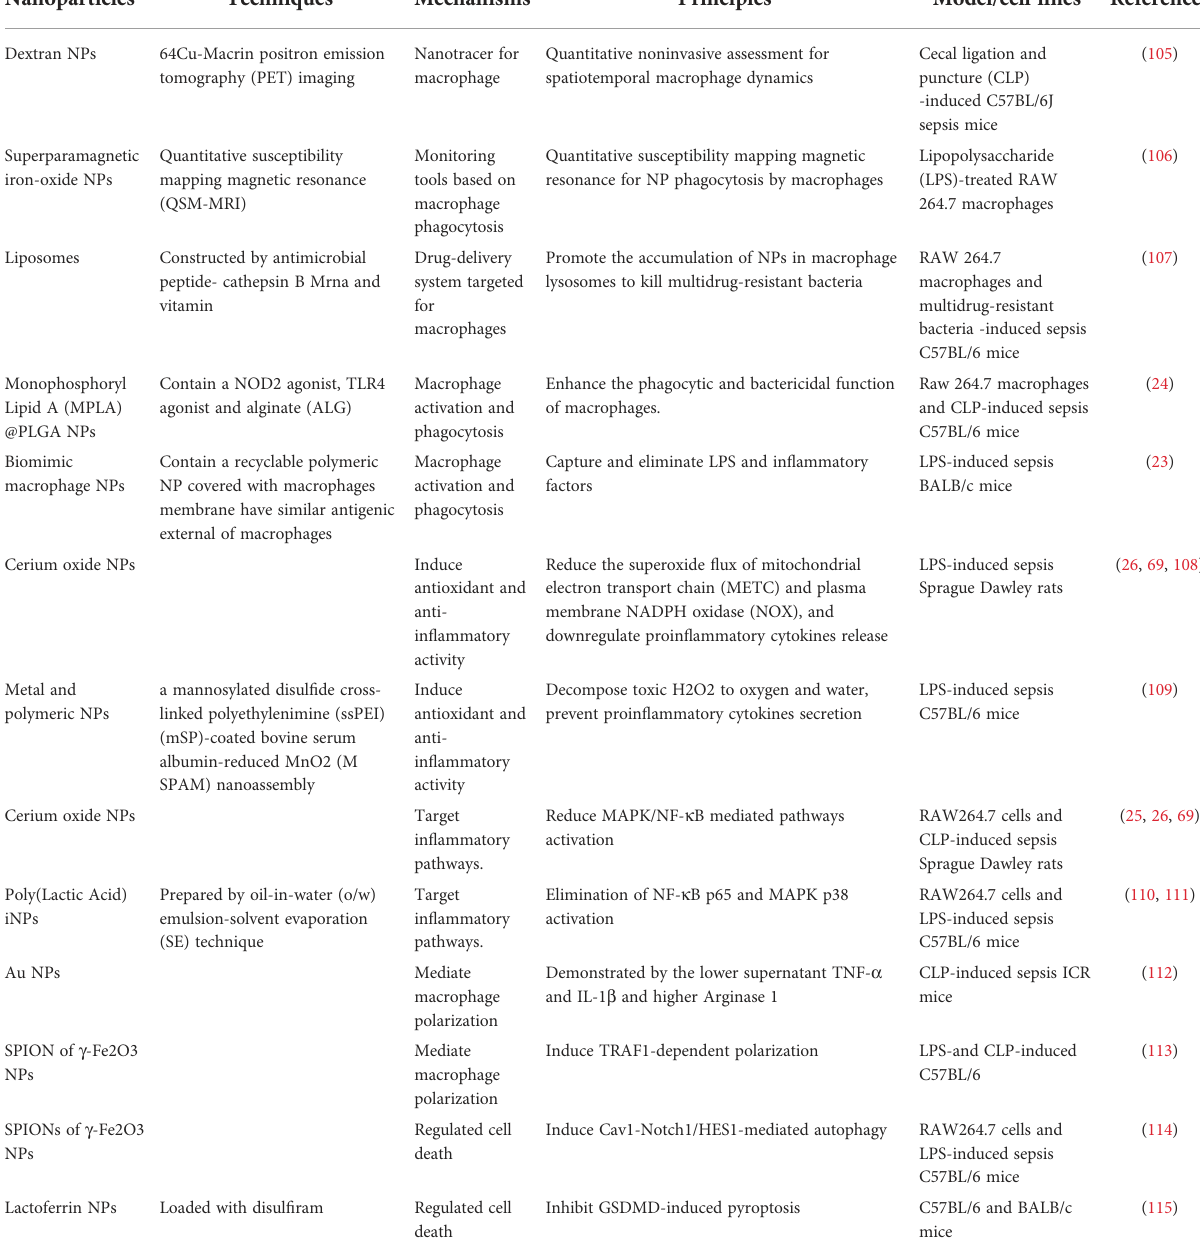
TABLE 2 The classi fi cation and mechanism of nanoparticles targeting macrophages in sepsis.